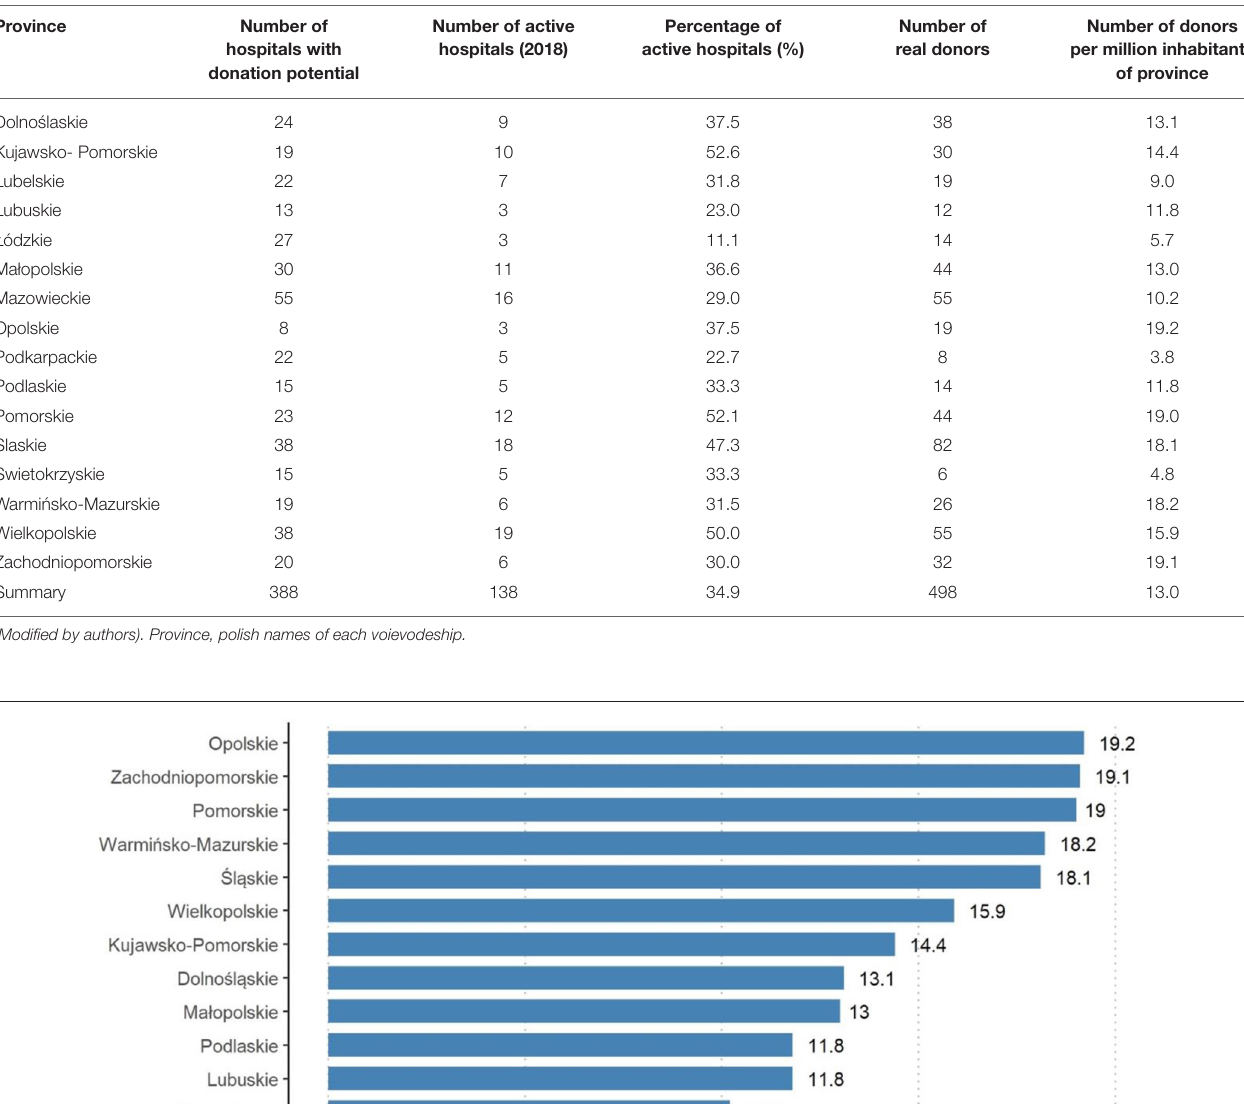
For all the statistical tests the level of statistical significance was defined as 0.05. The analyses were conducted using R program